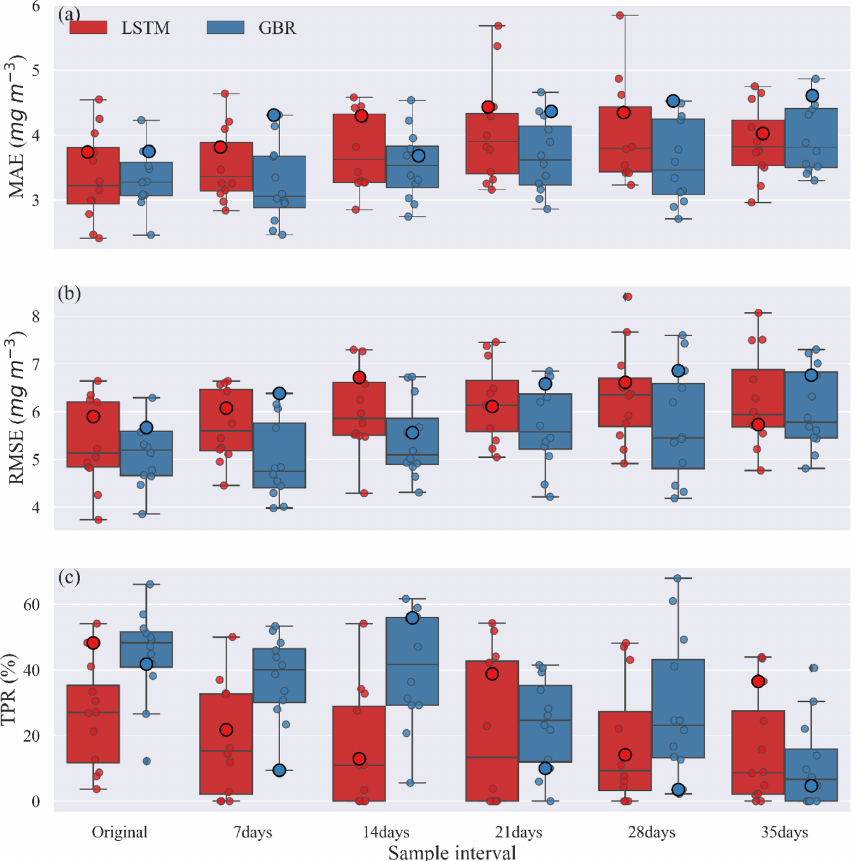
Figure 5. Comparisons of (a) MAE, (b) RMSE, and (c) TPR between GBR and LSTM during the testing period created under various sample intervals. Circles along the box show the result from the testing period of all shuffled training–testing year combinations, and the bigger circles represent 2004–2016 training and 2017–2020 testing year combination, as used in Fig.